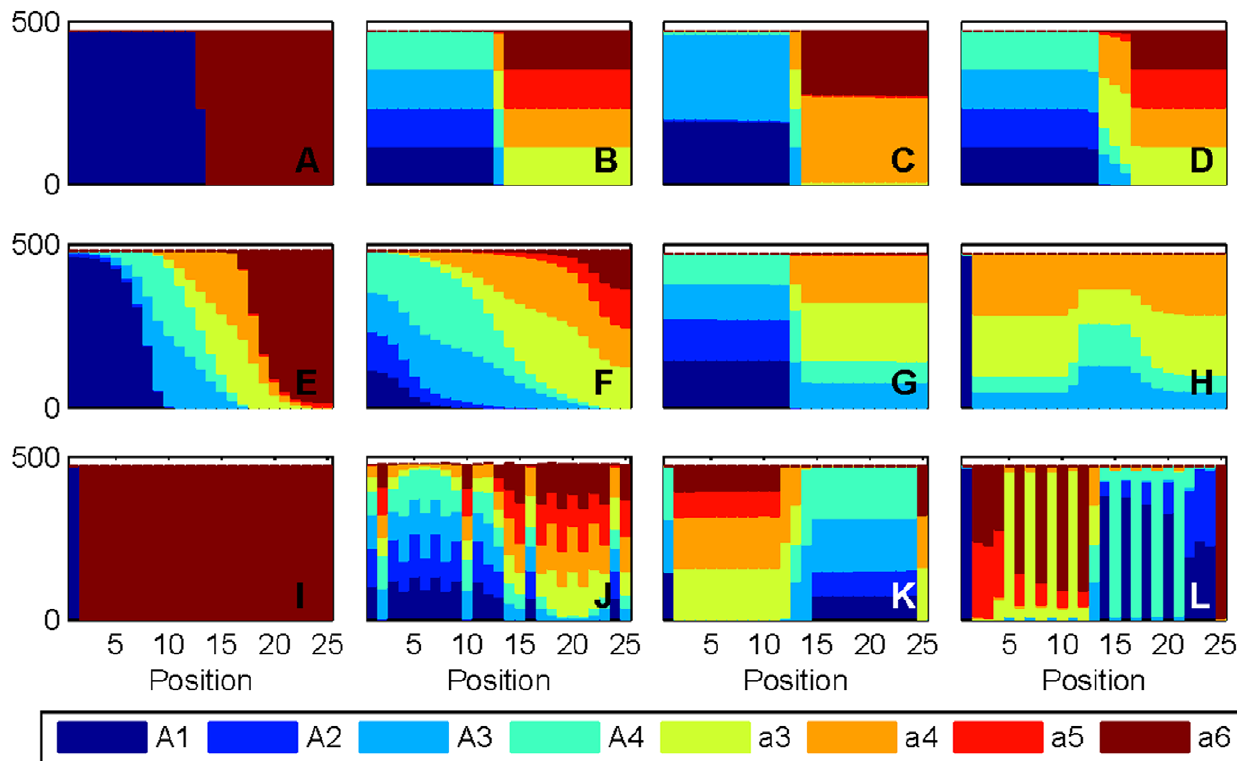
Figure 3. Representative sampling of different model outcomes. Each panel represents a stacked bar plot showing transect population totals (summed across y ) by phenogenotype at position x . Distributions are uniform across transects (independent of position y ) except for fine scale mosaics (3J). Parameters other than v 1 or v 2 are 0 unless otherwise specified. Scheme abbreviations: (Co)mmon, (Gr)oup, (M)atch, (Sh)ift. A) Area I, Co; B) Area I, M, c 1 =5%; C) Area I, Co, c 2 =10 2 6 , c 1 =.01%; D) Area I, Sh, c 1 =5%; E) Area I, Gr, c 1 =.01%, v 3 =10 2 2 ; F) Area I, M, c 2 =10 2 6 , c 1 =.5%, v 3 =10 2 2 ; G) Area I, Sh, c 2 =10 2 6 , c 1 =1%; H) Area III, Sh, c 2 =10 2 4 ; I) Area III, Sh; 3J) Area II, M, v 3 =10 2 2 , c 1 =5%; 3K) Area III, Co, c 2 =10 2 6 ; 3L) Area IV, M, c 2 =10 2 6 .